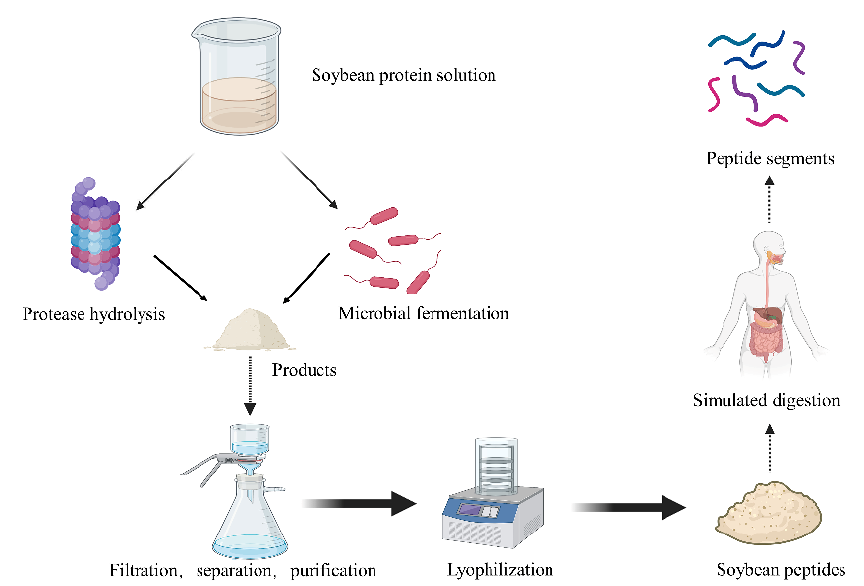
Figure 3. Preparation process of soybean peptide segments (some picture elements are from Bio- Render).